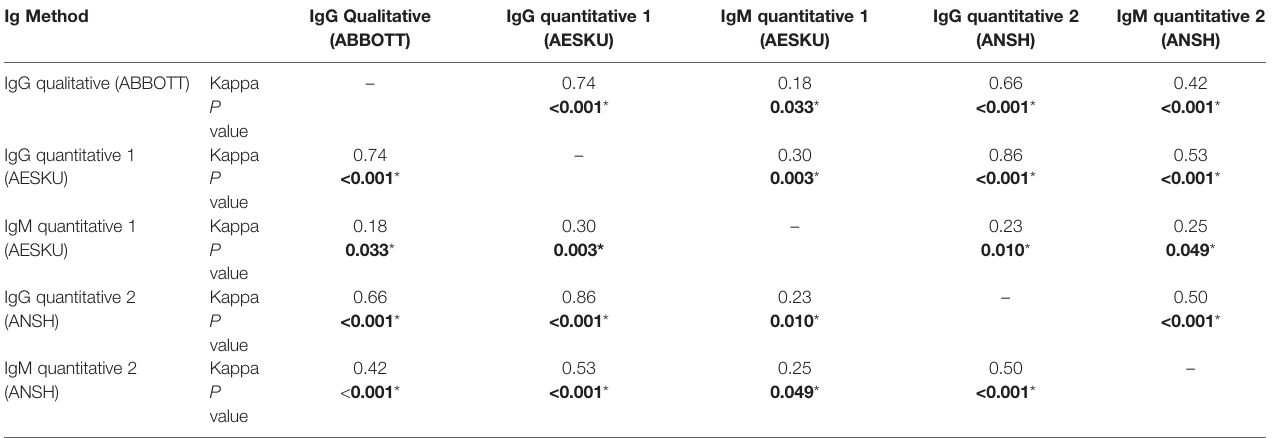
TABLE 3 | Agreement between different IgG and IgM testing methods (pooled